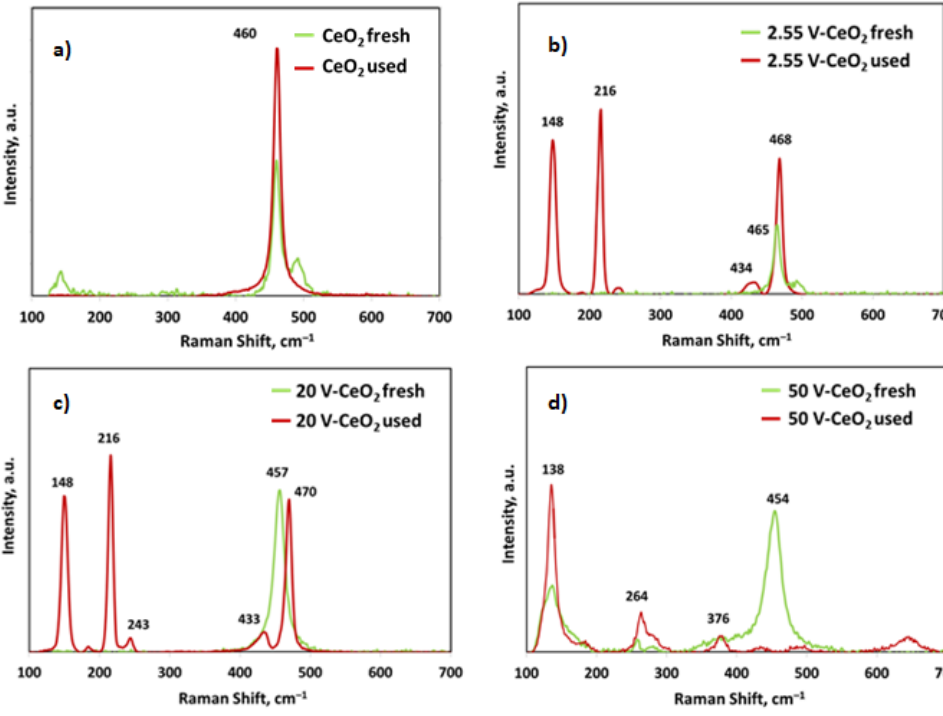
Figure 8. Raman spectra of fresh and used catalysts: CeO 2 ( a ), 2.55 V-CeO 2 ( b ), 20 V-CeO 2 ( c ), 50 V-CeO 2 ( d ).